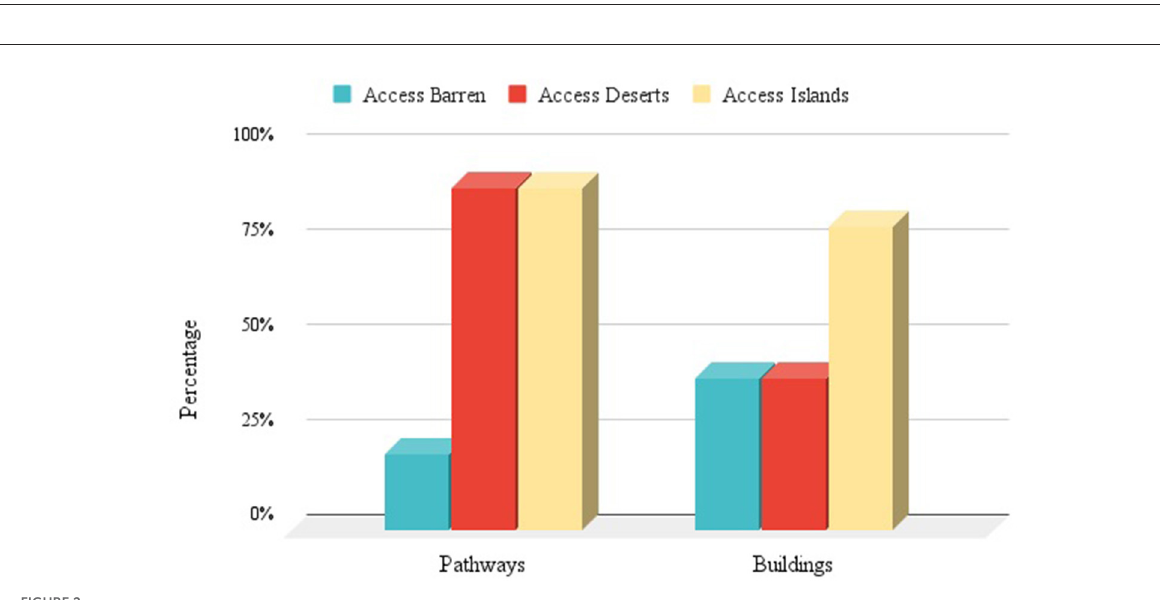
FIGURE2 Three Derived Concepts—shows three concepts derived from the data, including Access Islands (yellow) in which pathway and building access are both high; Access Deserts (red) in which pathway access is high but building access is low; and Access Barrens (blue) in which both pathway and building access are low. In Access Islands, a person using a mobility device can move around most or all of an area and get into most or all buildings. In Access Deserts, one can move around most of an area but cannot get into many of the buildings. In Access Barren, it is difficult to move around an area or get into many